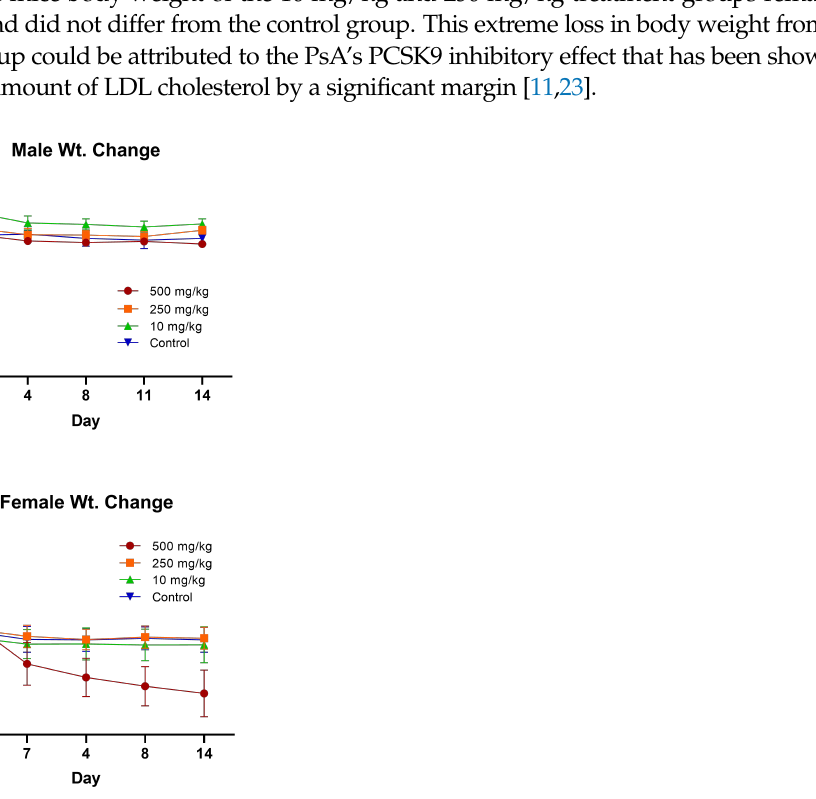
Figure 5. Single oral dose PsA treatment effects on the body weight of male and female Swiss albino mice. Weight was recorded at 1, 4, 8, 11, and 14 d for treatment and control groups. Data shown as mean ± SEM for n = 5/sex/group.